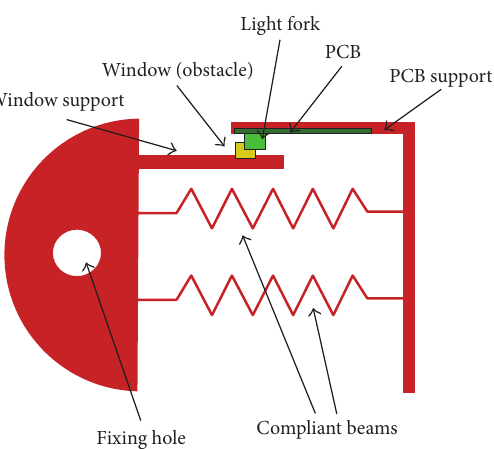
Figure 3: Scheme of the sensor structure and component arrange-